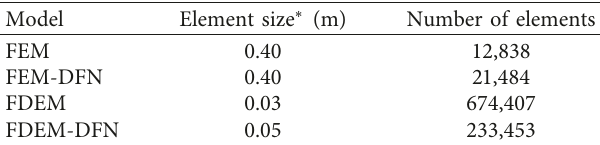
Figure 2: Tunnel model configuration created in Irazu (left) and in RS2 (right). The geometrical characteristics of the excavation and the applied geostatic stresses correspond to the ones recorded and monitored at the URL Test Tunnel. Table 4: Model configuration specifications. The intact model configurations (FEM and FDEM) and the fractured model con- figurations (FEM-DFN and FDEM-DFN) are listed.